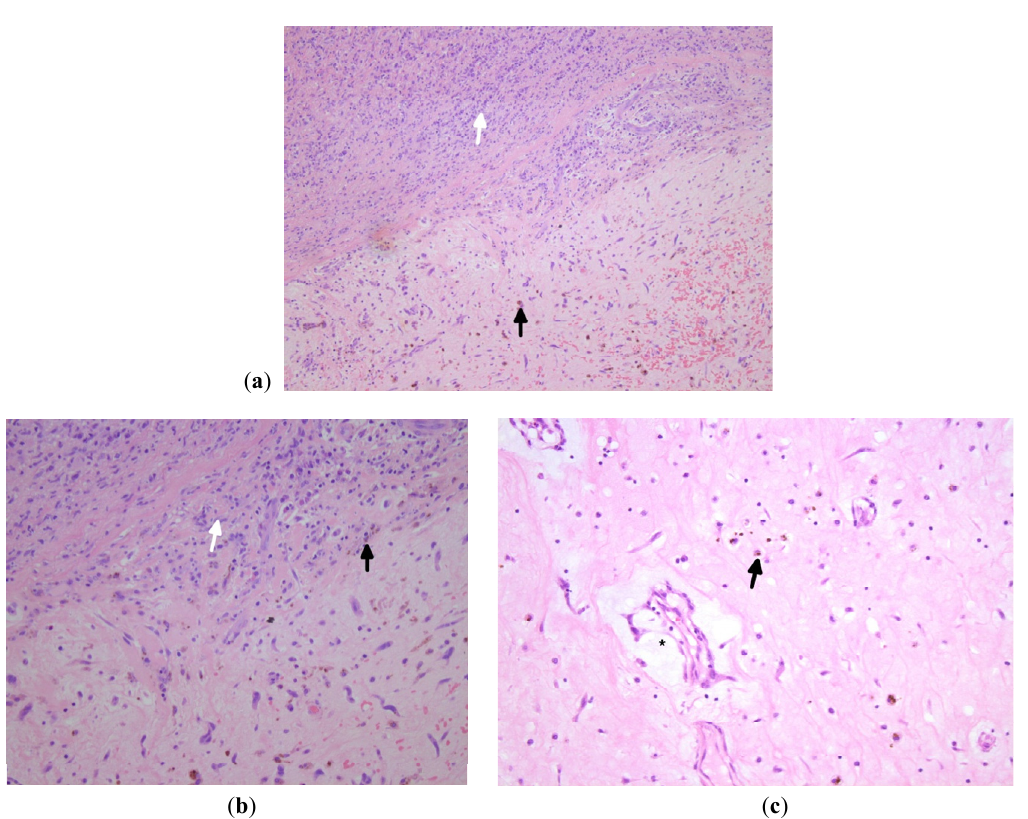
Figure 5. ( a ) Section shows chronic inflammatory cells (lymphocytes and plasma cells (white arrow) and hemosiderin-laden macrophages (black arrow) at the base of the lesion; ( b ) Higher magnification of the same; ( c ) Higher magnification showing hemosiderin-laden macrophages (black arrow) and ring structure (asterisks) (( a – c ): Stain: Hematoxylin and